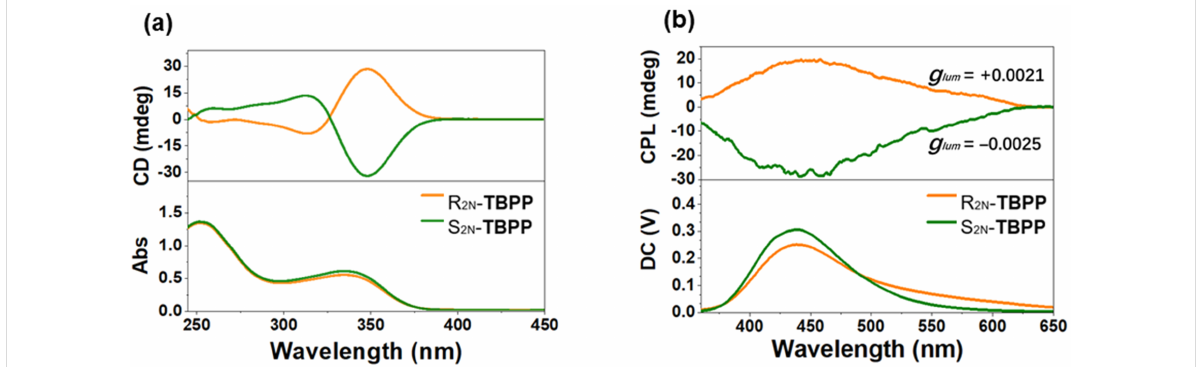
Figure 1: Ground-state and excited-state chirality of R 2N - TBPP and S 2N - TBPP . (a) CD spectra of R 2N - TBPP and S 2N - TBPP . (b) CPL spectra of R 2N - TBPP and S 2N - TBPP excited at 350 nm.